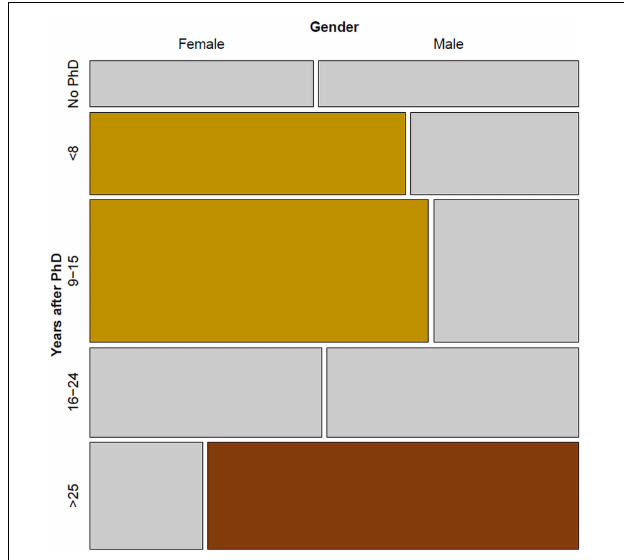
FIGURE 2 | Ocean4Biotech inquiry respondents’ data. The plot represents the respondents’ categories (gender and seniority level, in science typically denoted by years after obtaining Ph.D.). The area of the squares is proportional to the number of respondents from each of the categories. Colored areas represent overrepresented categories, with categories overrepresented by women colored in yellow, while categories overrepresented by men colored in